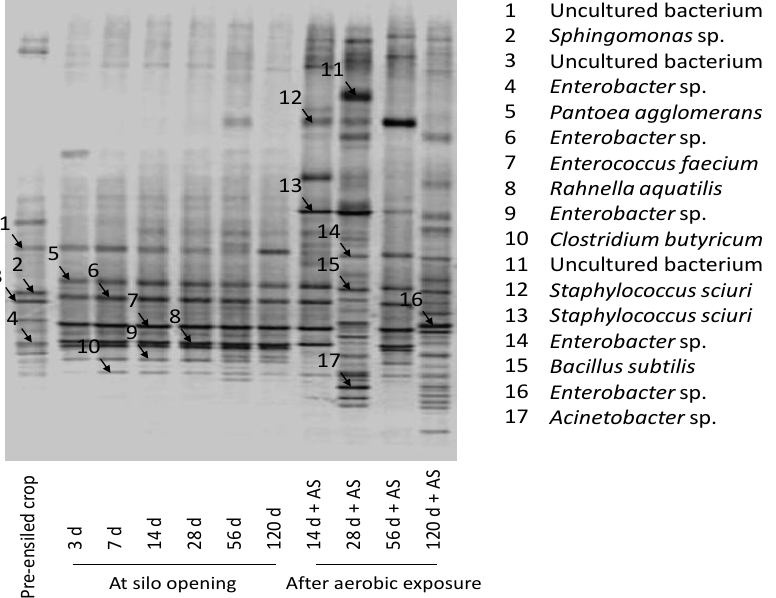
Figure 1. Bacterial communities in the ensiling process of direct-cut Italian ryegrass silage. Silos were opened after 3, 7, 14, 28, 56, and 120 d and a 7-d aerobic stability test was conducted for the silages from the latter 4